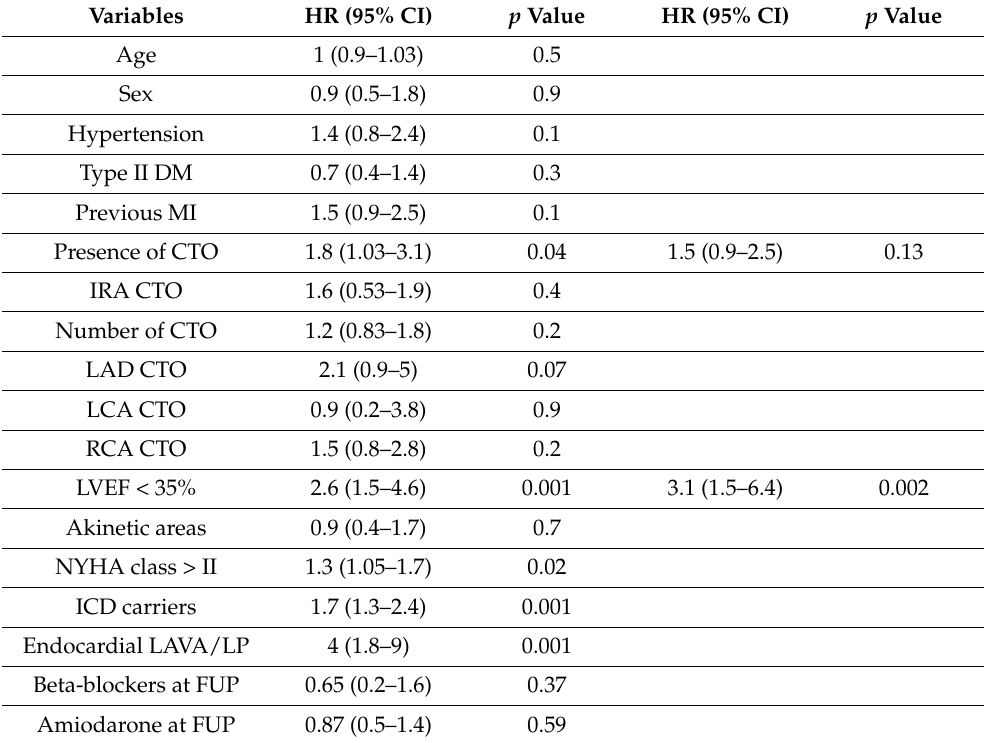
Table legend: DM: diabetes mellitus; MI: myocardial infarction; CTO: chronic total occlusion; ICD: implantable cardioverter defibrillator; IRA: infarct-related artery; LAD: left anterior descending artery; LCA: left circumflex artery; LAVA: local abnormal ventricular activities; LP: late potentials; LVEF: left ventricular ejection fraction; MI: myocardial infarction; RCA: right coronary artery; LVEF: left ventricular ejection fraction; NYHA: New York Heart Association; FUP: